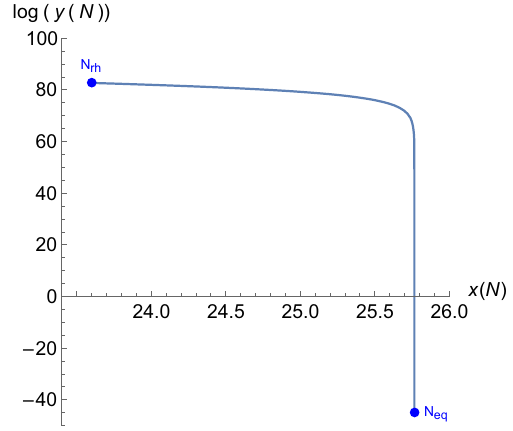
Fig. 1 Left graph: The reduced densities ¯ ρ m (blue curve), ¯ ρ r (red curve), and ¯ ρ ϕ (green curve) in log scale, from reheating to matter- radiation equality have been shown. Right graph: The density parame-